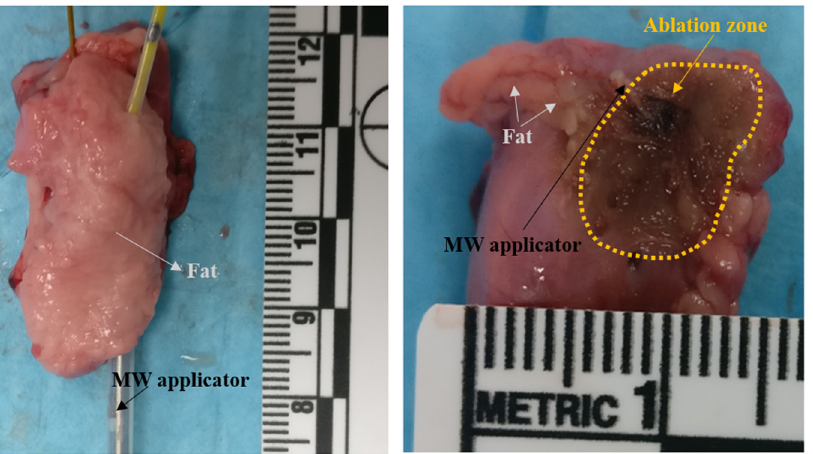
Figure 6. Section of the ablation zone obtained ex vivo in a porcine adrenal gland: The triaxial monopole MW applicator is placed on the surface of the gland and covered by fat, then it is excited at 5.8 GHz. The ablation zone in adrenal gland is marked (not visible in